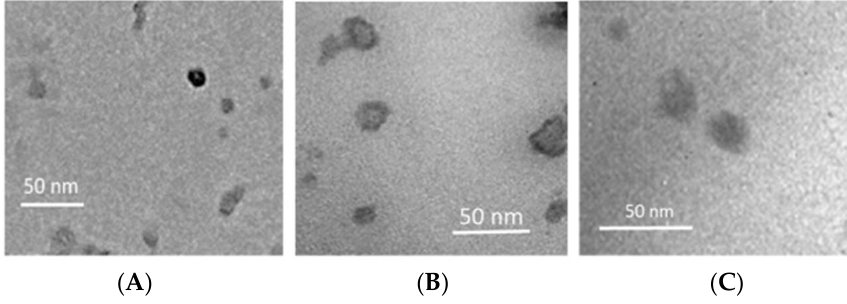
Figure 2. Transmission electron microscopy (TEM) images of lipid nanocarriers containing RSV 1% w / w . ( A ) NE RSV; ( B ) SLN RSV; ( C ) NLC6 RSV.